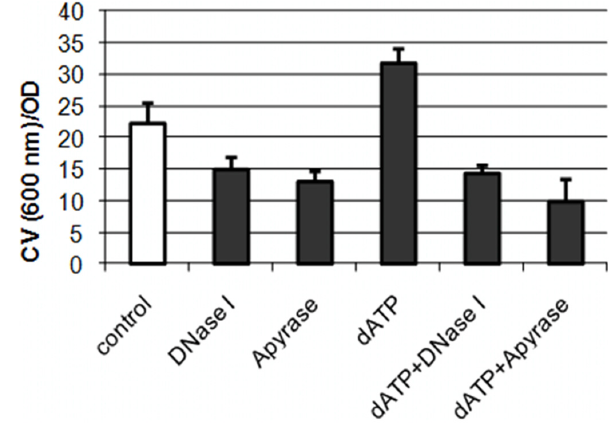
Figure 2. Quantification of biofilms developed by E.coli K-12 in 10% LB supplemented with different reagents: no addition of any reagents (control); DNase I (40 U/ml); Apyrase (200 mU/ml); dATP (400 m M); dATP (400 m M) and DNase I (40 U/ml); or dATP (400 m M) and Apyrase (200 mU/ml). Biofilms were examined after 16 hrs incubation after inoculation at 30 u C in a 96-well microtiter plate. Crystal violet staining assay was used to determine biofilm biomass.